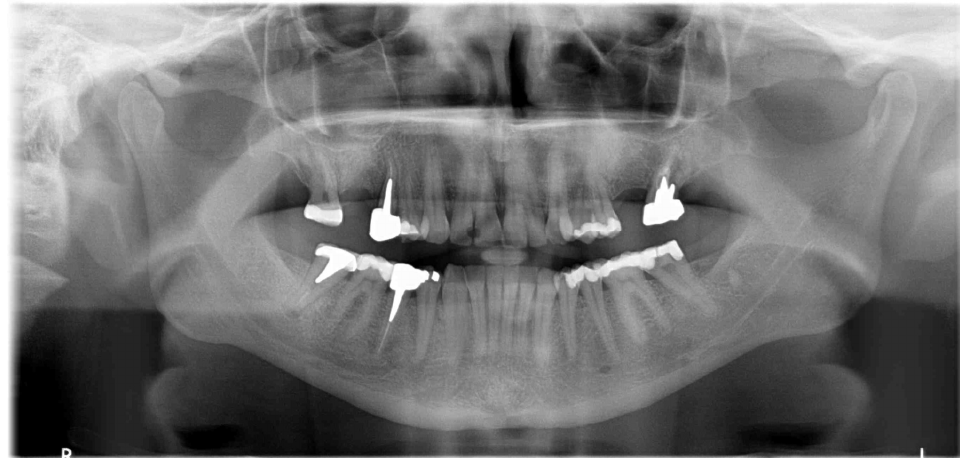
Figure 2. Orthopanoramic X-ray showing radiopacity in left upper jaw.